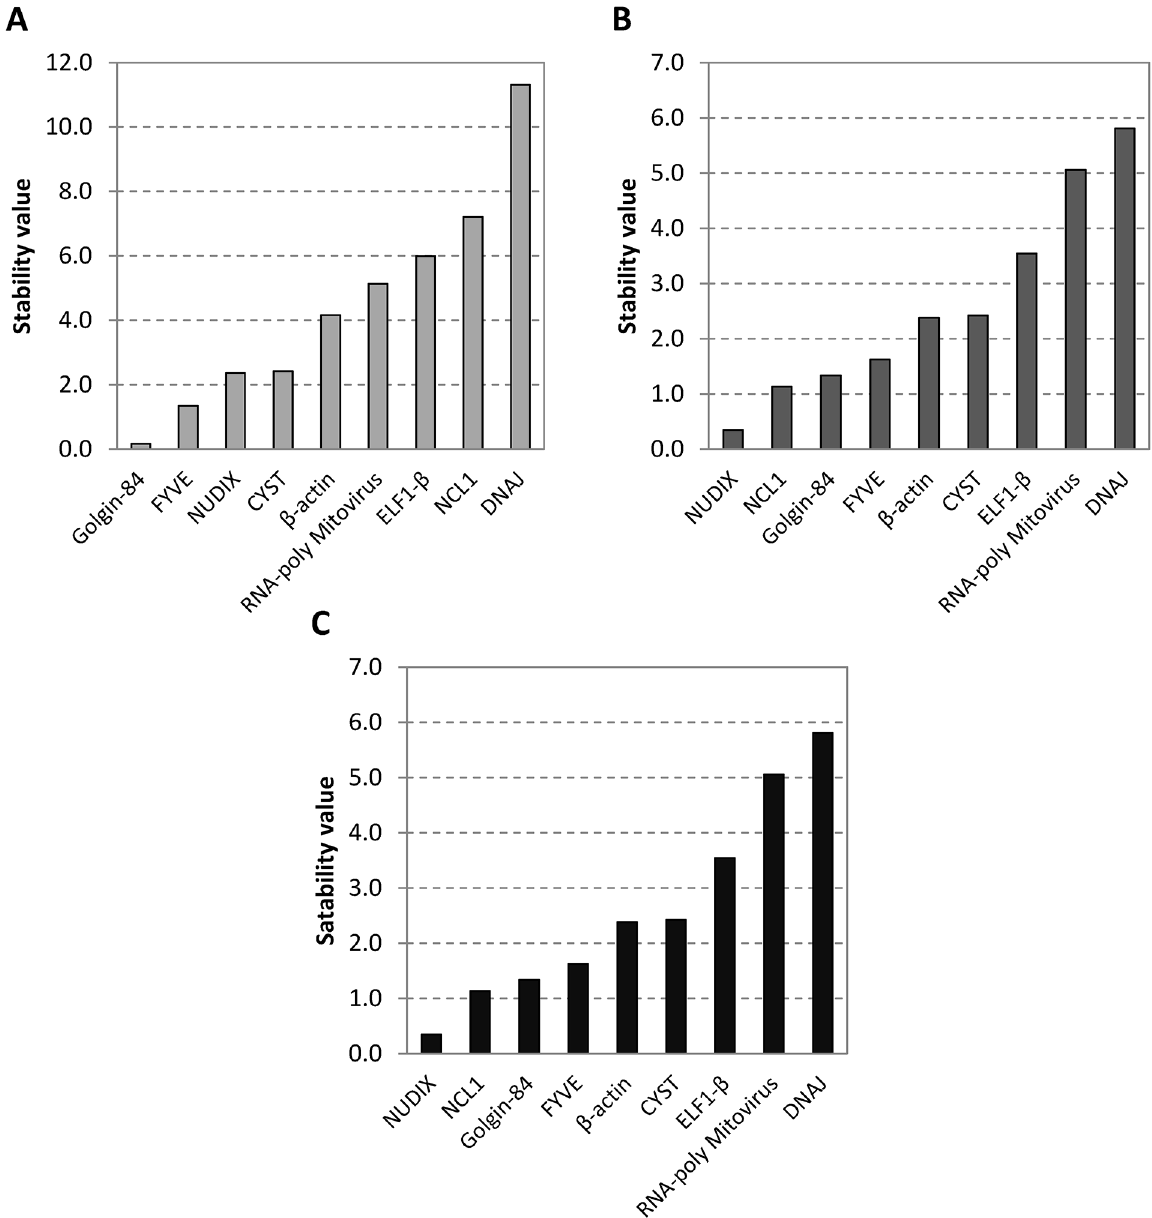
Fig 4. Intra- and intergroup variation of gene expression. The intragroup variation within the (A) control (non-stressed plants) and (B) stressed (plants under drought stress) and (C) the intergroup variation are